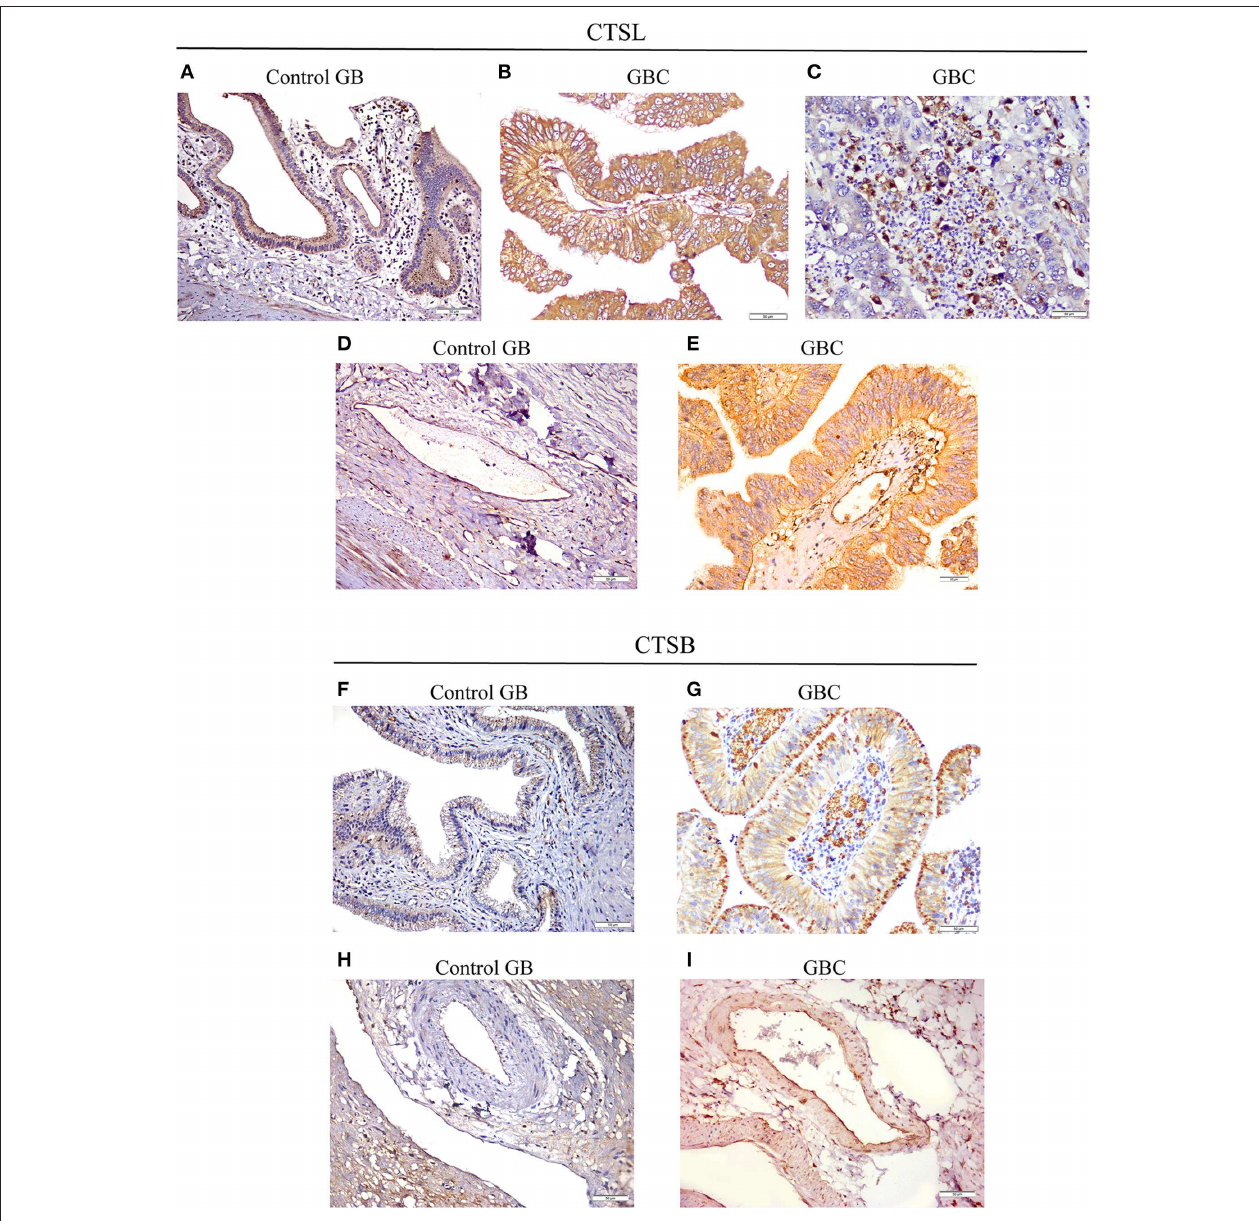
FIGURE 4 | Immunohistochemical analysis of CTSL and CTSB in GBC. (A) Control gallbladder (GB) tissue exhibiting faint immunopositivity for CTSL in epithelial cells of normal mucosa and (D) endothelial cells, while in GBC tissues prominent expression of CTSL was noted in (B) tumor cells, (C) tumor-associated macrophages and (E) tumor endothelial cells. Similarly, for CTSB, weak cytoplasmic positivity was observed in (F) normal mucosa and (H) endothelial cells of controls, whereas increased expression of CTSB was noted in the cytoplasmic compartment of (G) tumor cells, tumor-associated macrophages and (I) tumor endothelial cells of GBC tissues (Original magnification × 200, scale bar 50 µ